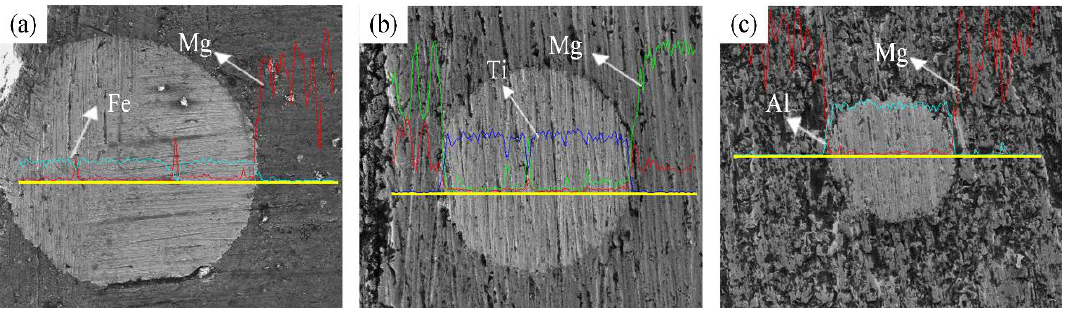
Figure 5. The energy dispersive spectroscopy (EDS) analysis of MIMC composites: ( a ) magnesium matrix composites interpenetrated by stainless steel reinforcement (MISC); ( b ) magnesium matrix composites interpenetrated by titanium alloy reinforcement (MITC); ( c ) magnesium matrix composites interpenetrated by aluminum alloy reinforcement